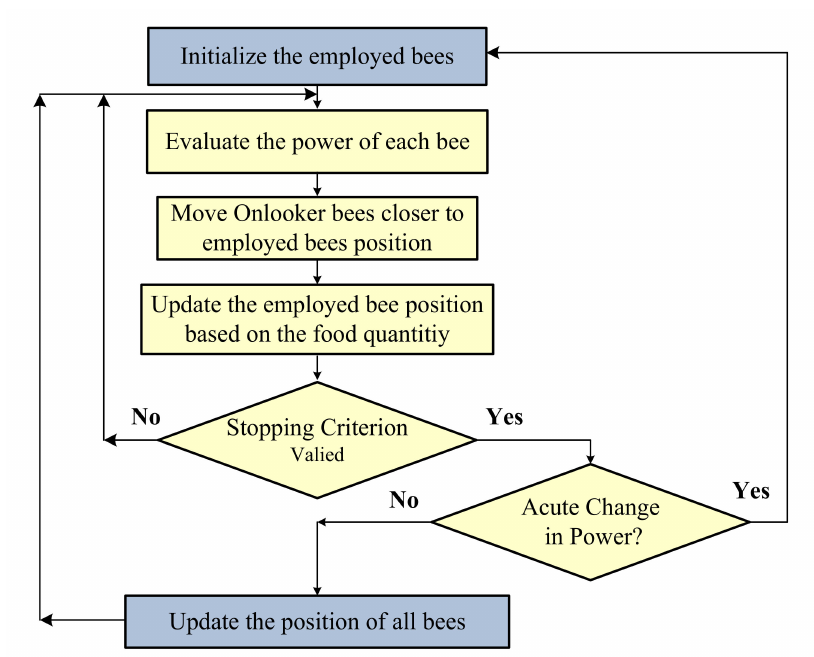
Figure 9. The flowchart of the artificial bee colony